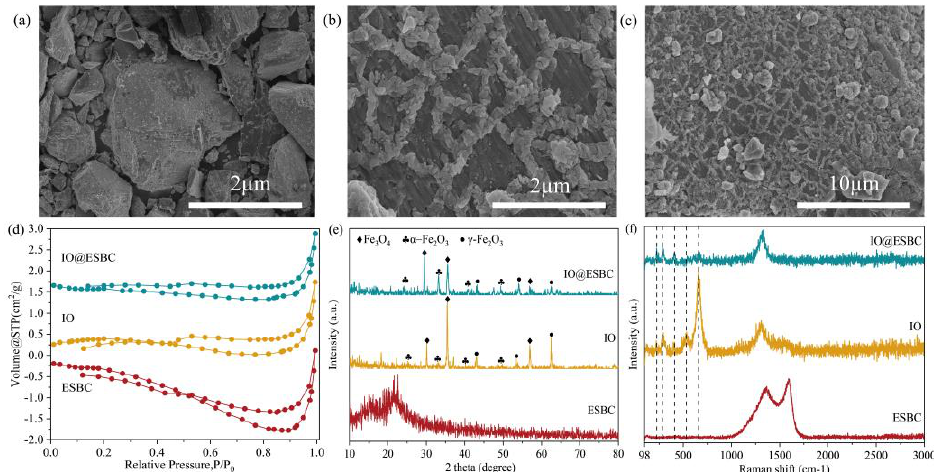
Figure 1. ( a ) SEM images of IO; ( b ) SEM images of ESBC; ( c ) SEM images of IO@ESBC; ( d ) N 2 ad- sorption-desorption curve of samples; ( e ) XRD patterns of samples; ( f ) Raman spectra of samples.